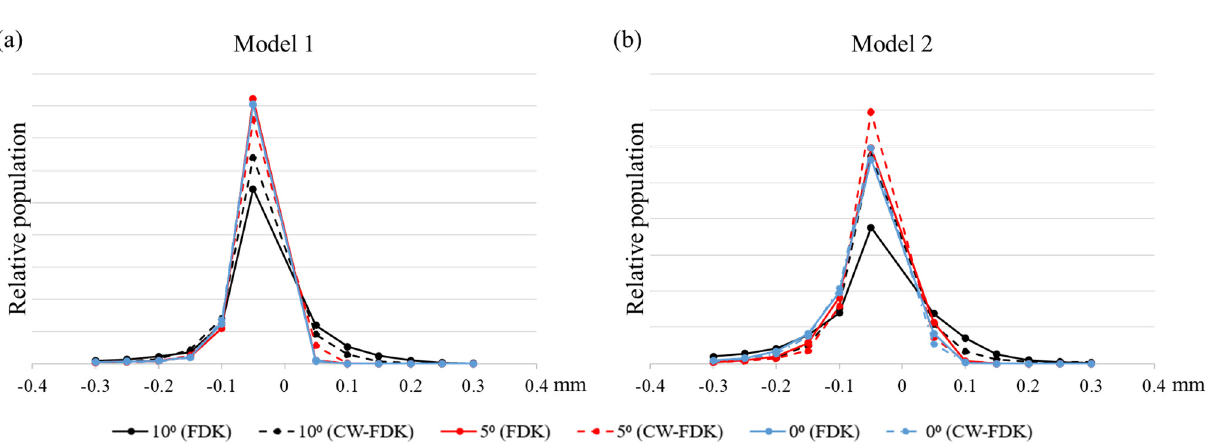
Figure 10. The relative population of the deviations from the reference of ( a ) Model 1 and ( b ) Model 2 at three different cone-beam angles of 0, 5, and 10 degrees. The solid and dashed lines correspond to the cases of the FDK and CW-FDK algorithms. Table 1. The mean of positive deviations (MPD) and the mean of negative deviations (MND) in the 3D models.